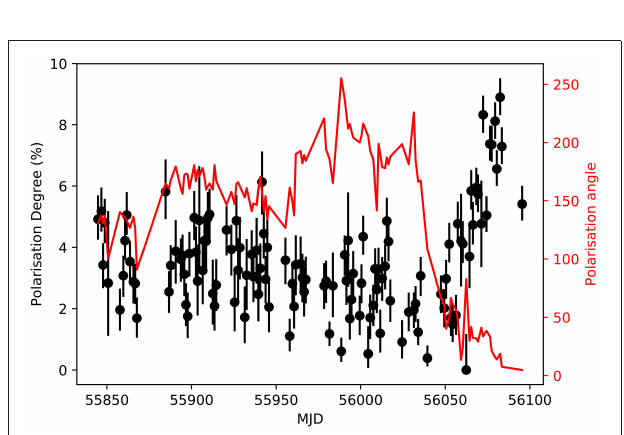
FIGURE 4 | Polarization angle and degree. The rotation of the angle can be seen around MJD 56040, right before the rise in the degree.